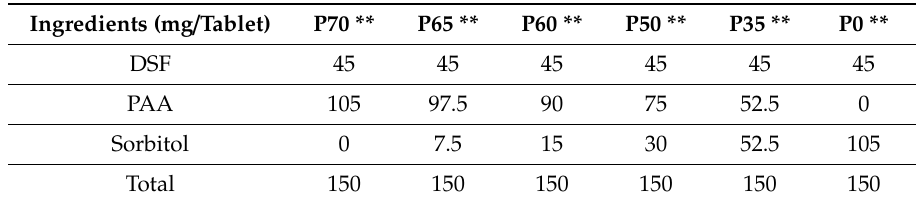
Table 2. Composition of Blend 1 * tablets **.